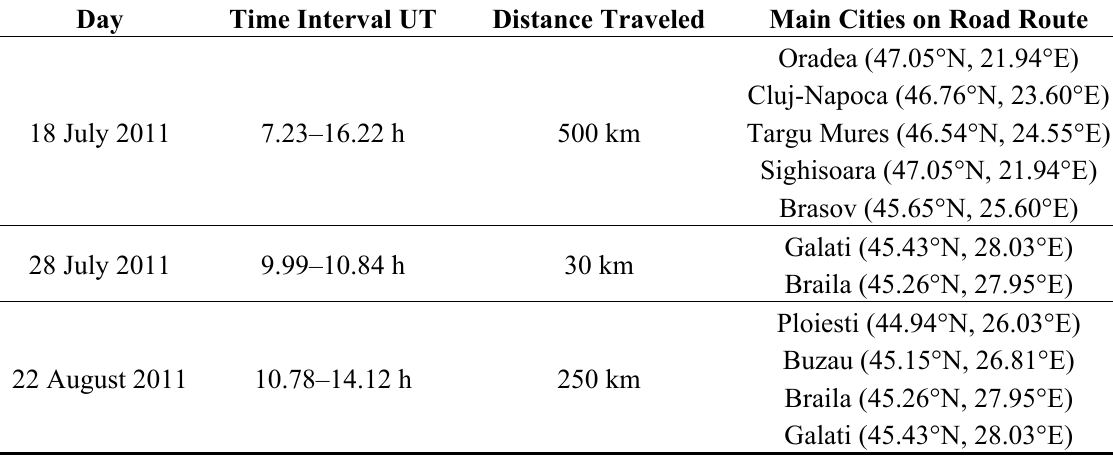
Table 1. Coordinates and temporal coverage of the three